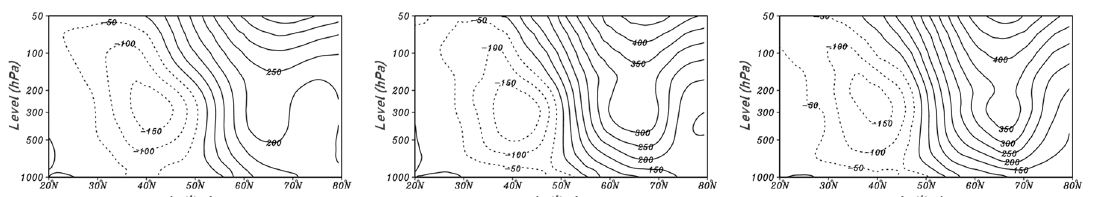
Figure 12. Latitude-pressure cross-section of anomaly of geopotential height (m) averaged over 120 ◦